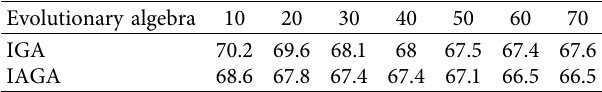
Table 2: Results of immune genetic algorithm and adaptive im- mune genetic algorithm.